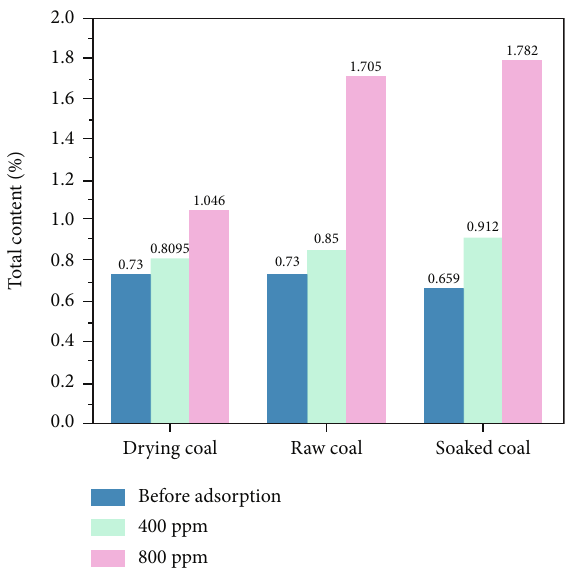
Figure 8: Fitting curve of water content and free H curve for the water content of the coal samples versus free state H S concentration at equilibrium was fi tted. As shown 2 in Figure 8, the linear correlation of the fi tted Equation (5) was good with R 2 of 0.99552.